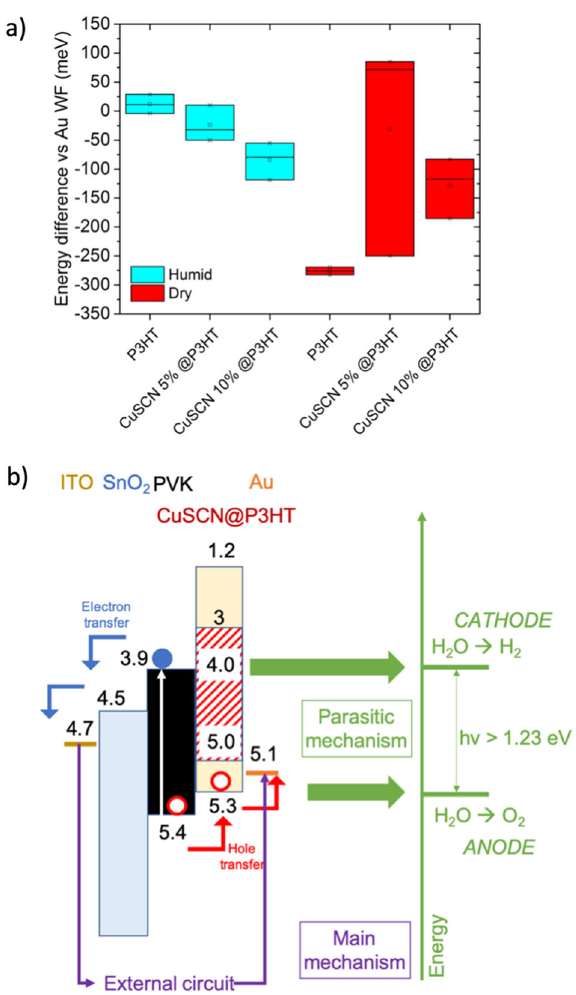
Fig. 5 HTM p-doping and energetics of the solar cell driven by the hypothesized occurrence of a water-splitting process. a Chart summarizing Kelvin probe analysis: “ humid ” and “ dry ” behavior are compared in different colors. The zero value in the y- axis represent the WF of Au. b Proposed mechanisms for the two processes happening within the WS-integrating PSC. The “ main mechanism ” (violet) is the regular working process of the PSC. The “ parasitic mechanism ” is the hyphotetical WS- process occurring at the perovskite/CuSCN@P3HT interface. This last one takes place because, during the endurance test in a water-saturated atmosphere, moisture, diffusing from the top of the device, is locally oxidized by the CuSCN-NP center contained in the composite HTM, forming in situ molecular oxygen, that p-dopes the semiconducting P3HT matrix. The required energy difference for WS is guaranteed by the valence band position of p-doped P3HT and Fermi level of CuSCN (indicated with the 4.0 value in the scheme) acting as, respectively, anode and cathode sites for the WS reaction, whereas the fl ow of the charges is supported by the built-in potential (in dark during the storage) or by the bias (during solar cell electrical